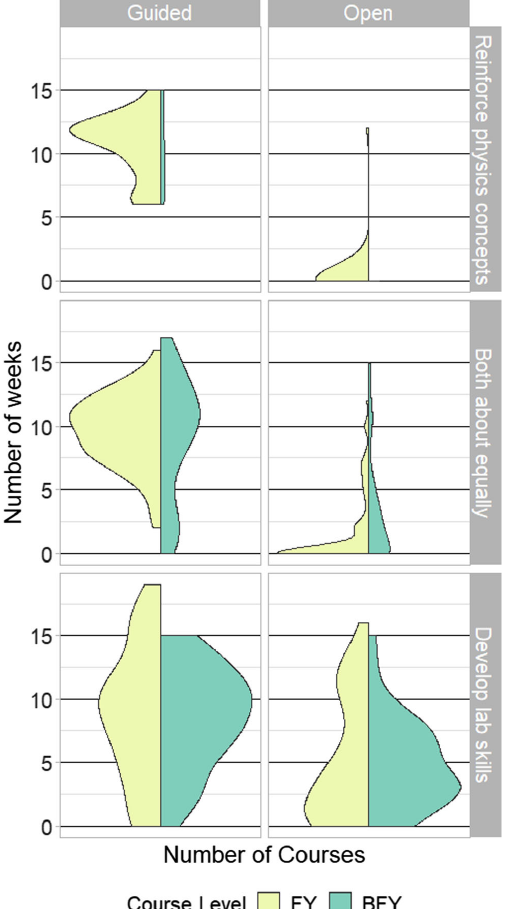
FIG. 3. Distribution of scores on the agency and modeling factors for courses broken out by course level and course goal. Higher factor scores indicate more frequent use of the items loaded on to that factor. The horizontal black lines indicate the means of each